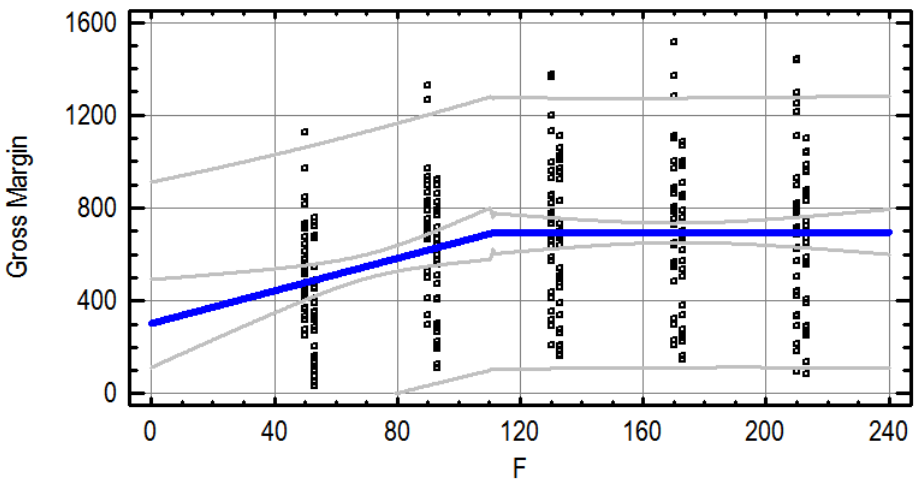
Figure 2. Observed and predicted gross margin (EUR·ha −1 ) depending on nitrogen doses (F, kg N·ha −1 ) (critical F rate (C) = 111.9 kg N·ha −1 , for F < C GM = 306 + 3.46*F, R 2 = 7.3%, for F > C GM = 693 EUR·ha −1 , n = 320).